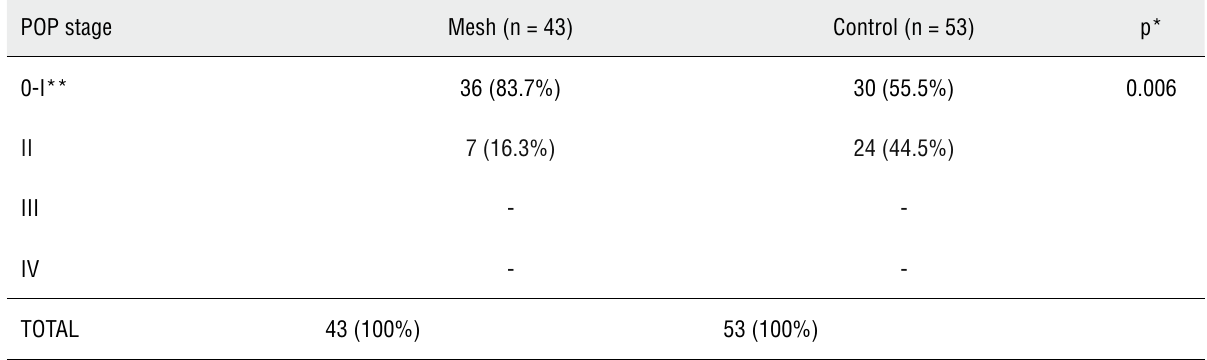
Table 3 - Cure rates according POP stage (POP-q). Results presented in frequency and